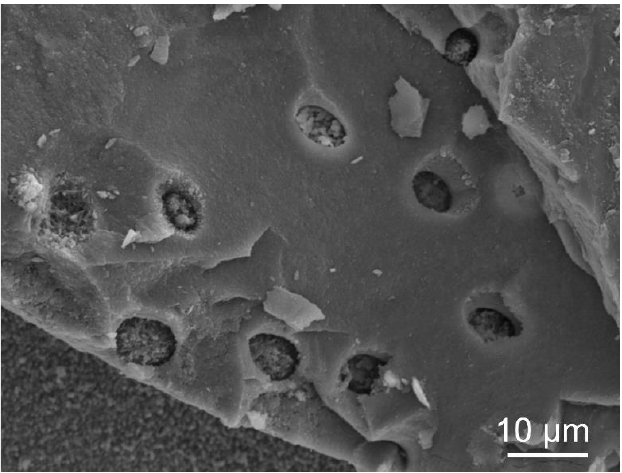
Figure 3. Micropores and homogeneous granular structure in Holoconularia from the Carboniferous of Russia.